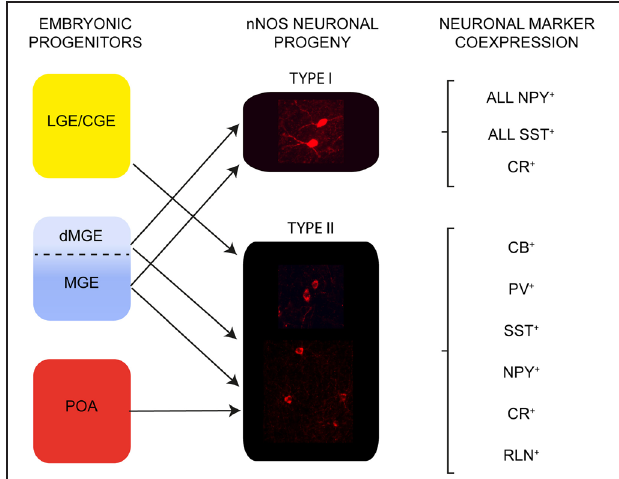
FIGURE 7 | The embryonic origin and neurochemical content of nNOS interneurons in the adult somatosensory mouse cortex. Type I cells originate in the MGE. Type II cells have a triple origin in the LGE/CGE, MGE and POA. All type I cells coexpress SST and NPY and some coexpress CR. Heterogeneity of neurochemical marker expression is observed in type II cells.